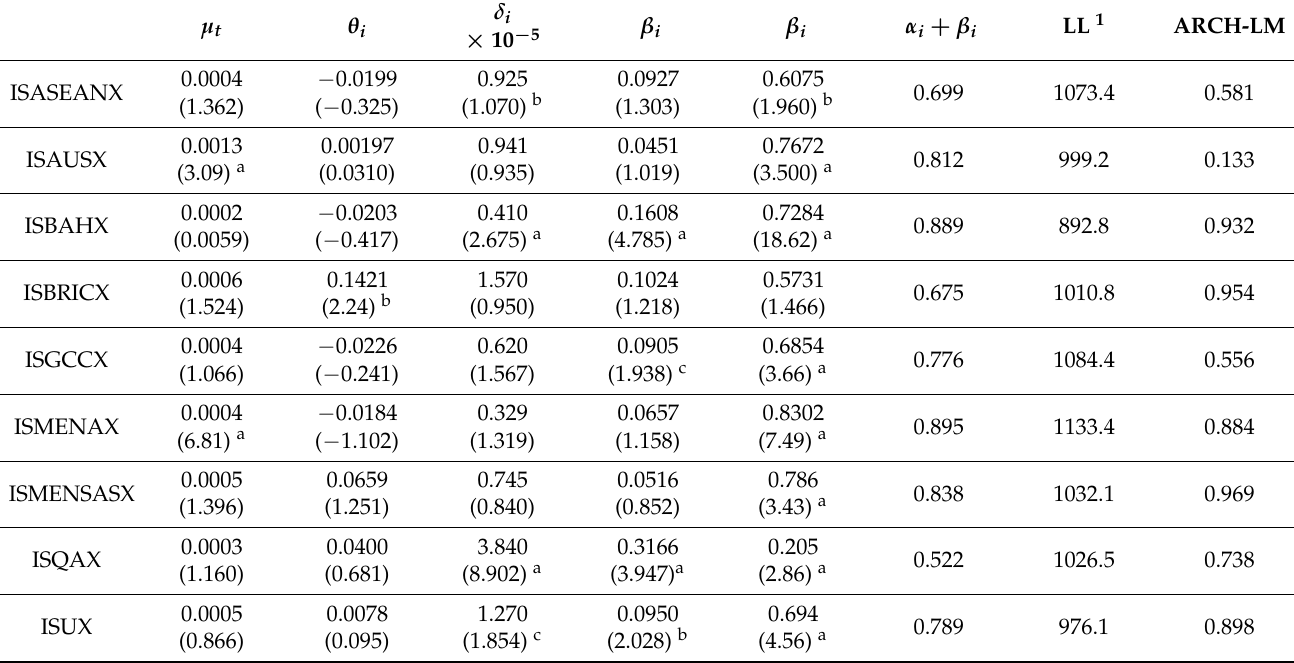
Table 8. GARCH (1, 1) pre-crisis